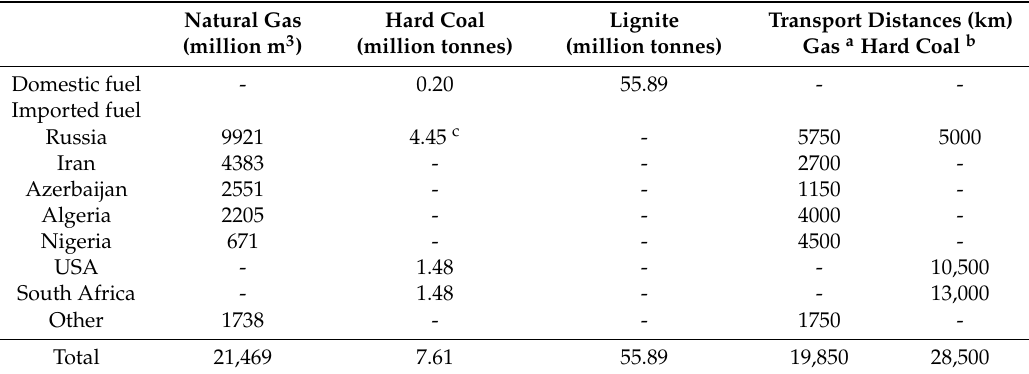
Table 3. The amount of fuels used for electricity generation in 2010